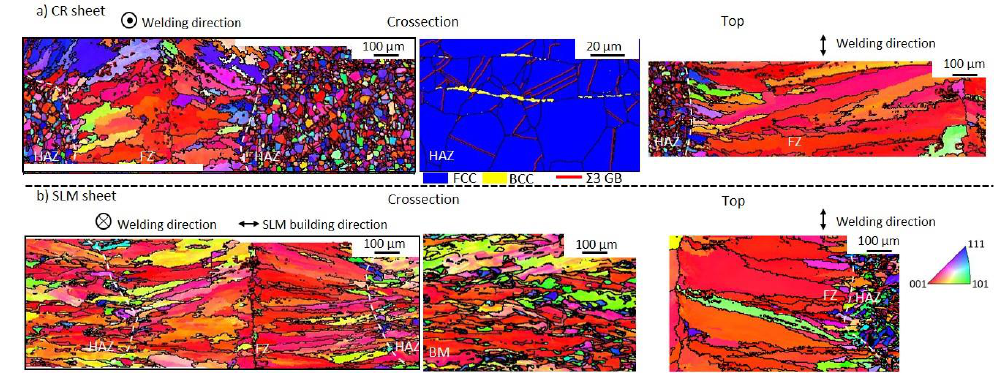
Figure 4. ( a ) (Left) SEM-EBSD inverse pole figure (IPF) X cross-section map of welded CR; (middle) phase map of the heat-affect area (HAZ) and SEM-EBSD inverse pole figure (IPF) X top map of welded CR (right). ( b ) SEM-EBSD inverse pole figure (IPF) X maps of cross-section welded SLM (left), base metal SLM (middle), and top welded SLM (right), respectively. Black lines correspond to random grain boundaries and red lines to Σ3 twin grain boundaries (GB).